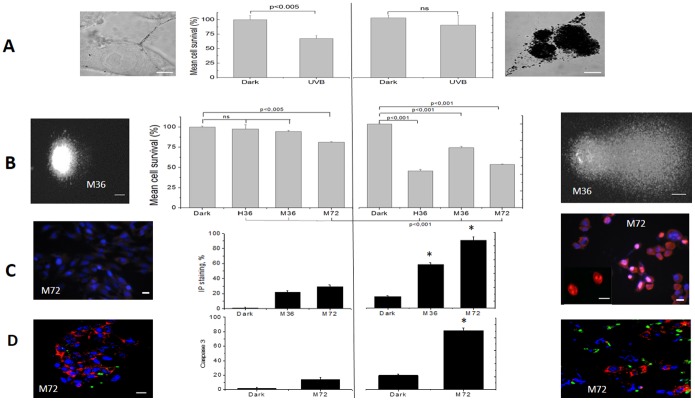
The effects of UVB and visible light in B16-F10 and human melanocyte cells.Left side: (no extra pigmentation); right side: cells subjected to the pigmentation protocol (M++++). (A) Viable cells (%) determined using the acridine orange fluorescence of B16-F10 cells that were maintained in the dark or with 4.5 J.cm−2 of UVB irradiation. The images are confocal optical microscopy images of the B16-F10 cells, CT (left) and M++++ (right). (B) The viable cells (%) were determined using the MTT colorimetric assay in the dark or with 36 J.cm−2 or 72 J.cm−2 of visible irradiation; murine B16-F10 cells are marked as either M36 or M72 depending on the light dose received. The human melanocytes (H36) only received a light dose of 36 J.cm−2. The images on the sides show comet assays performed using the CT and M++++ B16-F10 cells, 180 min after irradiation with a light dose of 36 J.cm−2
. (C) Propidium iodide incorporation in B16-F10 CT and M++++ cells in the dark and after treatment with 72 J.cm−2 of visible light. The images on the sides show typical images used for quantifying the PI incorporation. (D) Caspase 3 activation in B16-F10 CT and M++++ cells in the dark and after exposure to 72 J.cm−2 of visible light. The images on the side are typical for quantifying caspase 3 activation. (*) p<0.001.